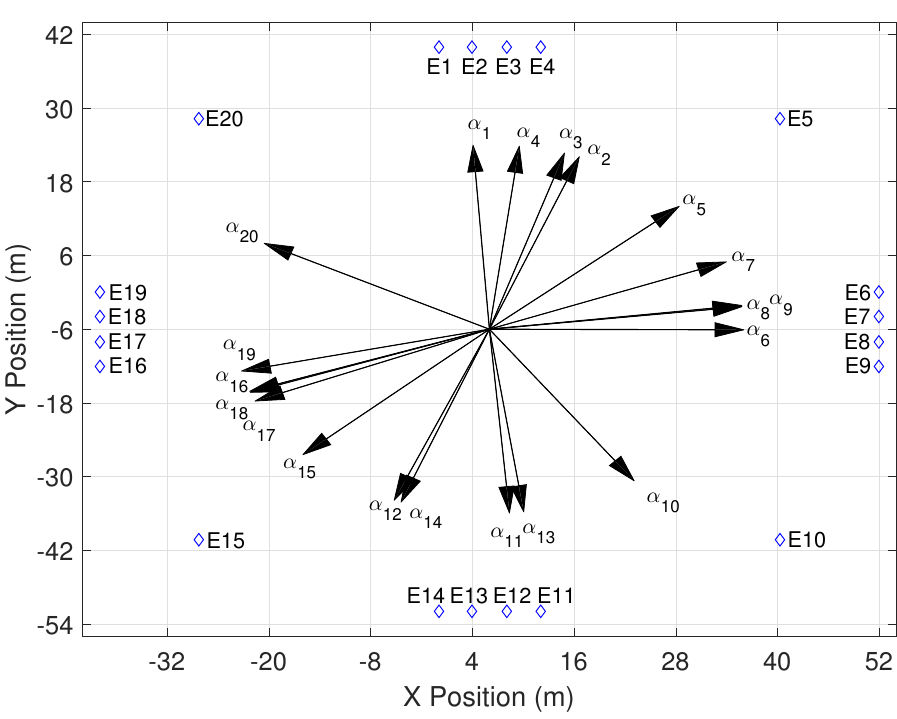
Figure 12. Estimation of directions towards sound event origins. The angular RMSE is